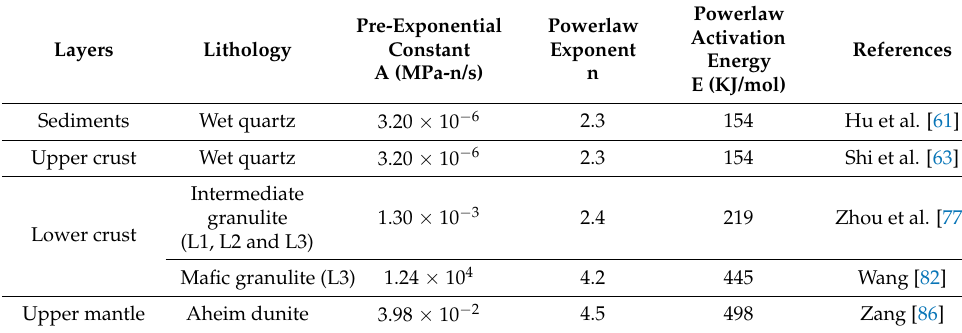
Table 2. Material properties used for construction of initial lithospheric rheology